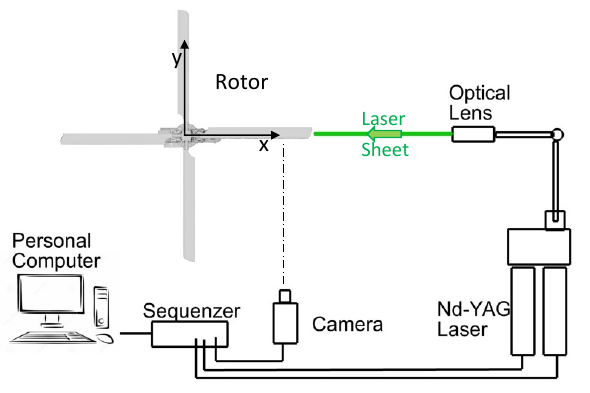
Figure 2. PIV layout: plan-view.